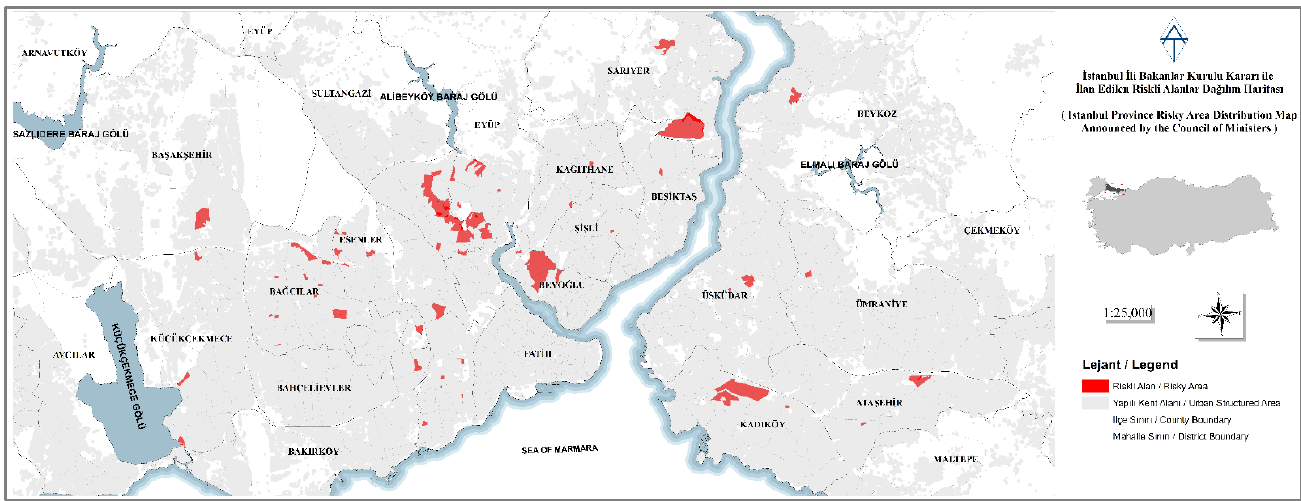
Figure 4. Istanbul Province Risky Area Distribution Map Announced by the Council of Ministers .